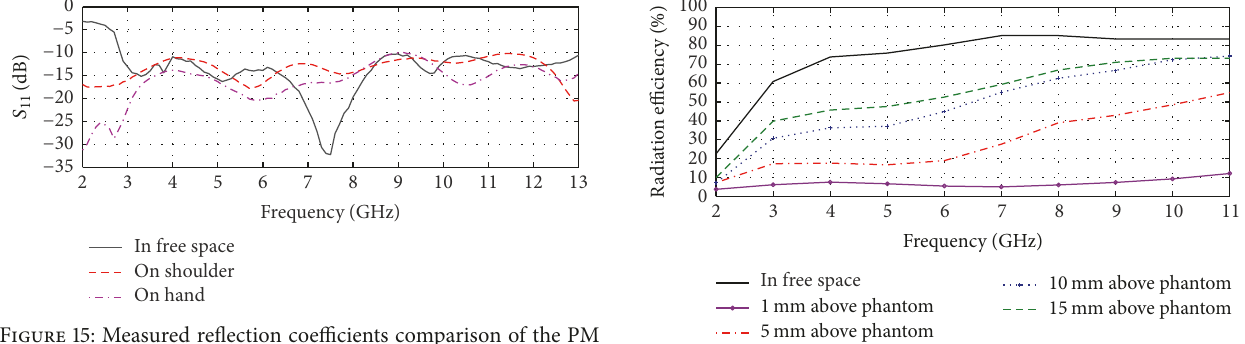
Figure 15: Measured reflection coefficients comparison of the PM antenna.